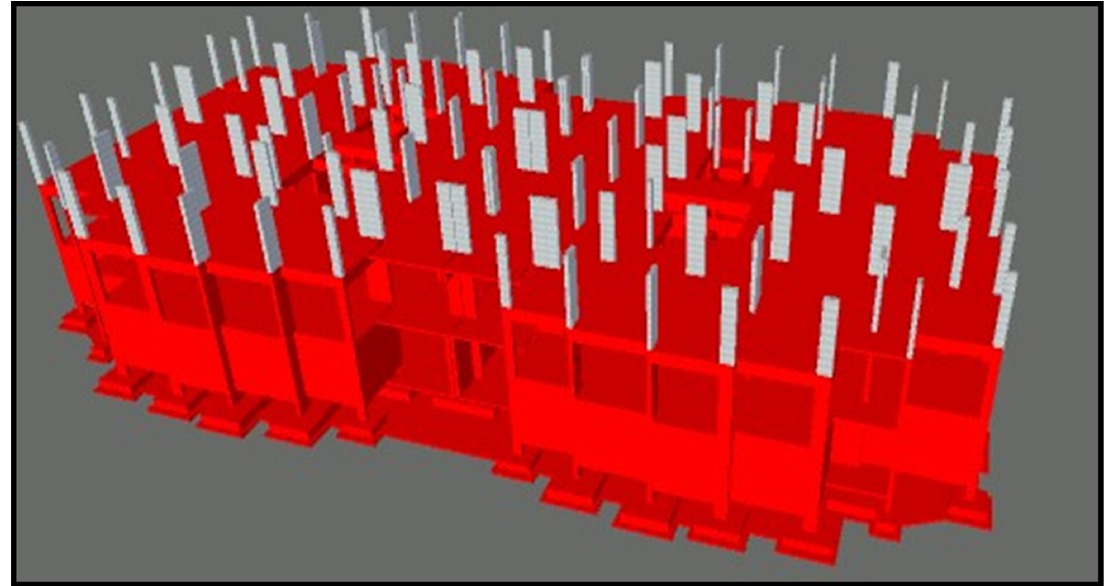
Figure 16. Critical activities appeared in red during the simulation.